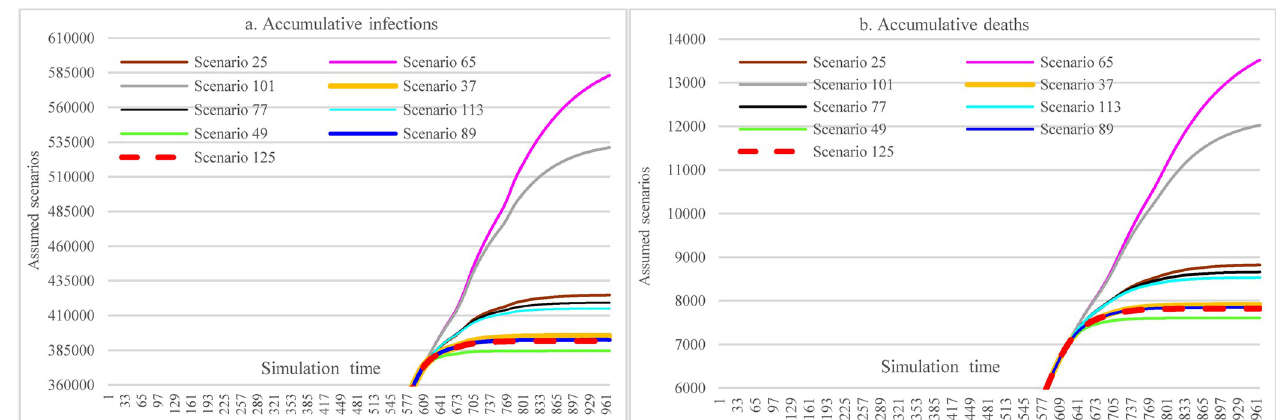
Fig 23. Increasing vaccination levels and mask-wearing adherence as compensation for the less stringent SDMs.